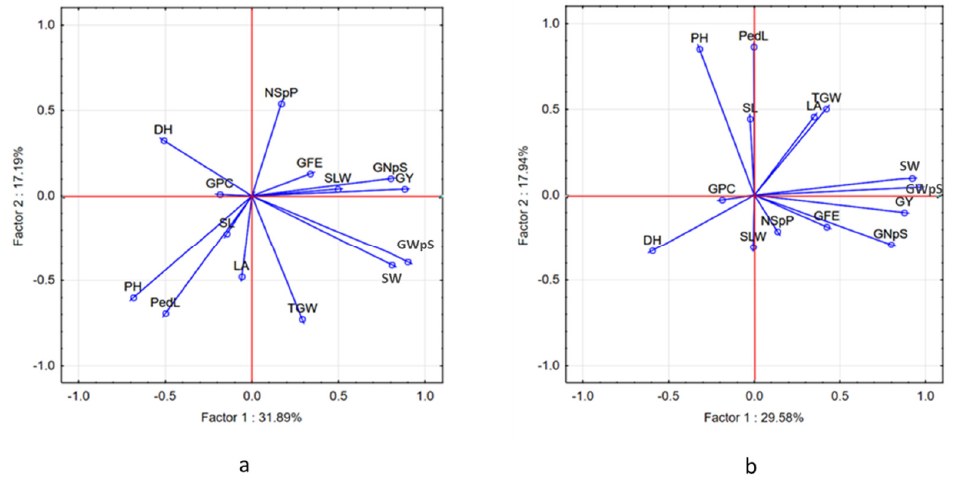
Figure 3. Principal component analysis (PCA), and biplot vectors of 14 traits measured in the 232 wheat accessions in two water regimes: ( a ) well-watered (W) and ( b ) water-limited (D). Key: grain yield (GY), grain protein content (GPC), spike weight (SW), grain weight per spike (GWpS), grain number per spike (GNpS), number of spikes per plot (NSpP), thousand-grain weight (TGW), the efficiency of grain filling (GFE), leaf area (LA), specific leaf weight (SLW), plant height including spike (PH), peduncle length (PedL), spike length (SL), days to heading (DH).